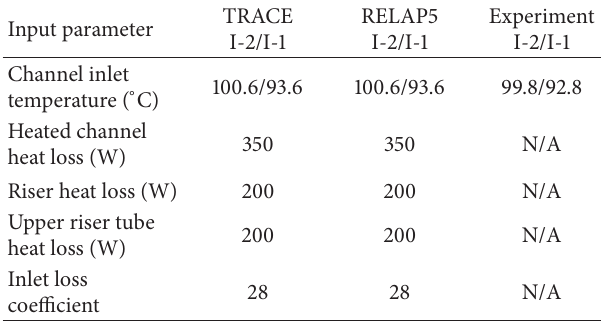
Table 4: Calibrated values of uncertain input parameters, tests I-2 and